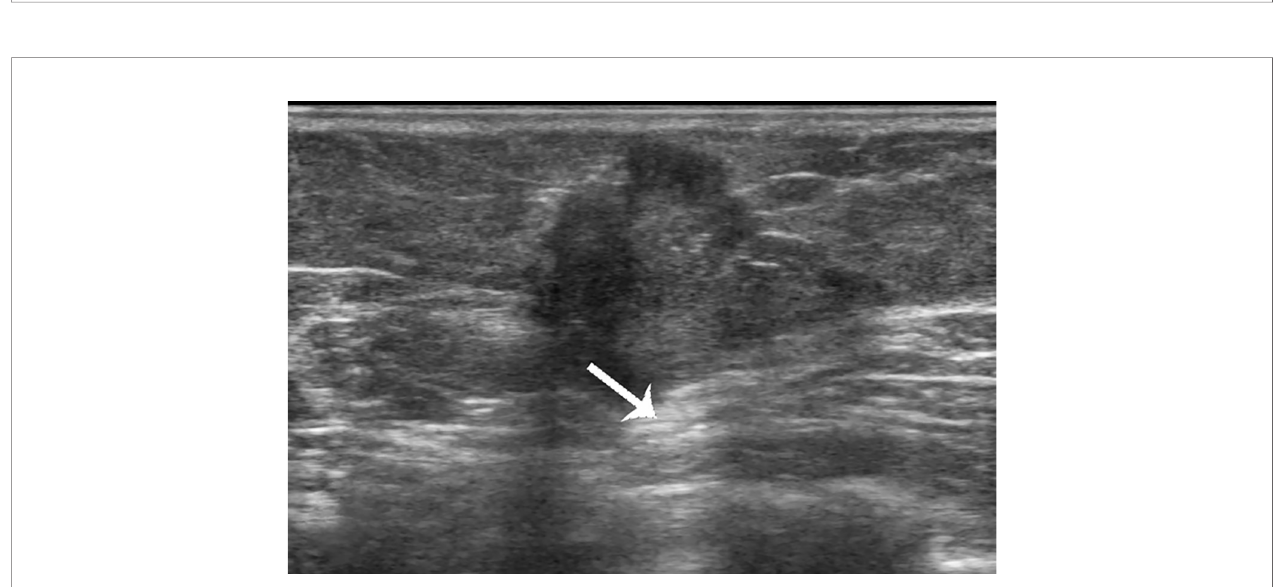
FIGURE 2 | Case 1: A 37-year-old woman with mucinous breast carcinoma with micropapillary pattern (MUMPC) presented with a hypoechoic mass (1.7 × 1.5 × 1.4 cm) in the left breast. The lesion had a non-circumscribed margin, irregular shape, and enhanced posterior echo (white arrow).